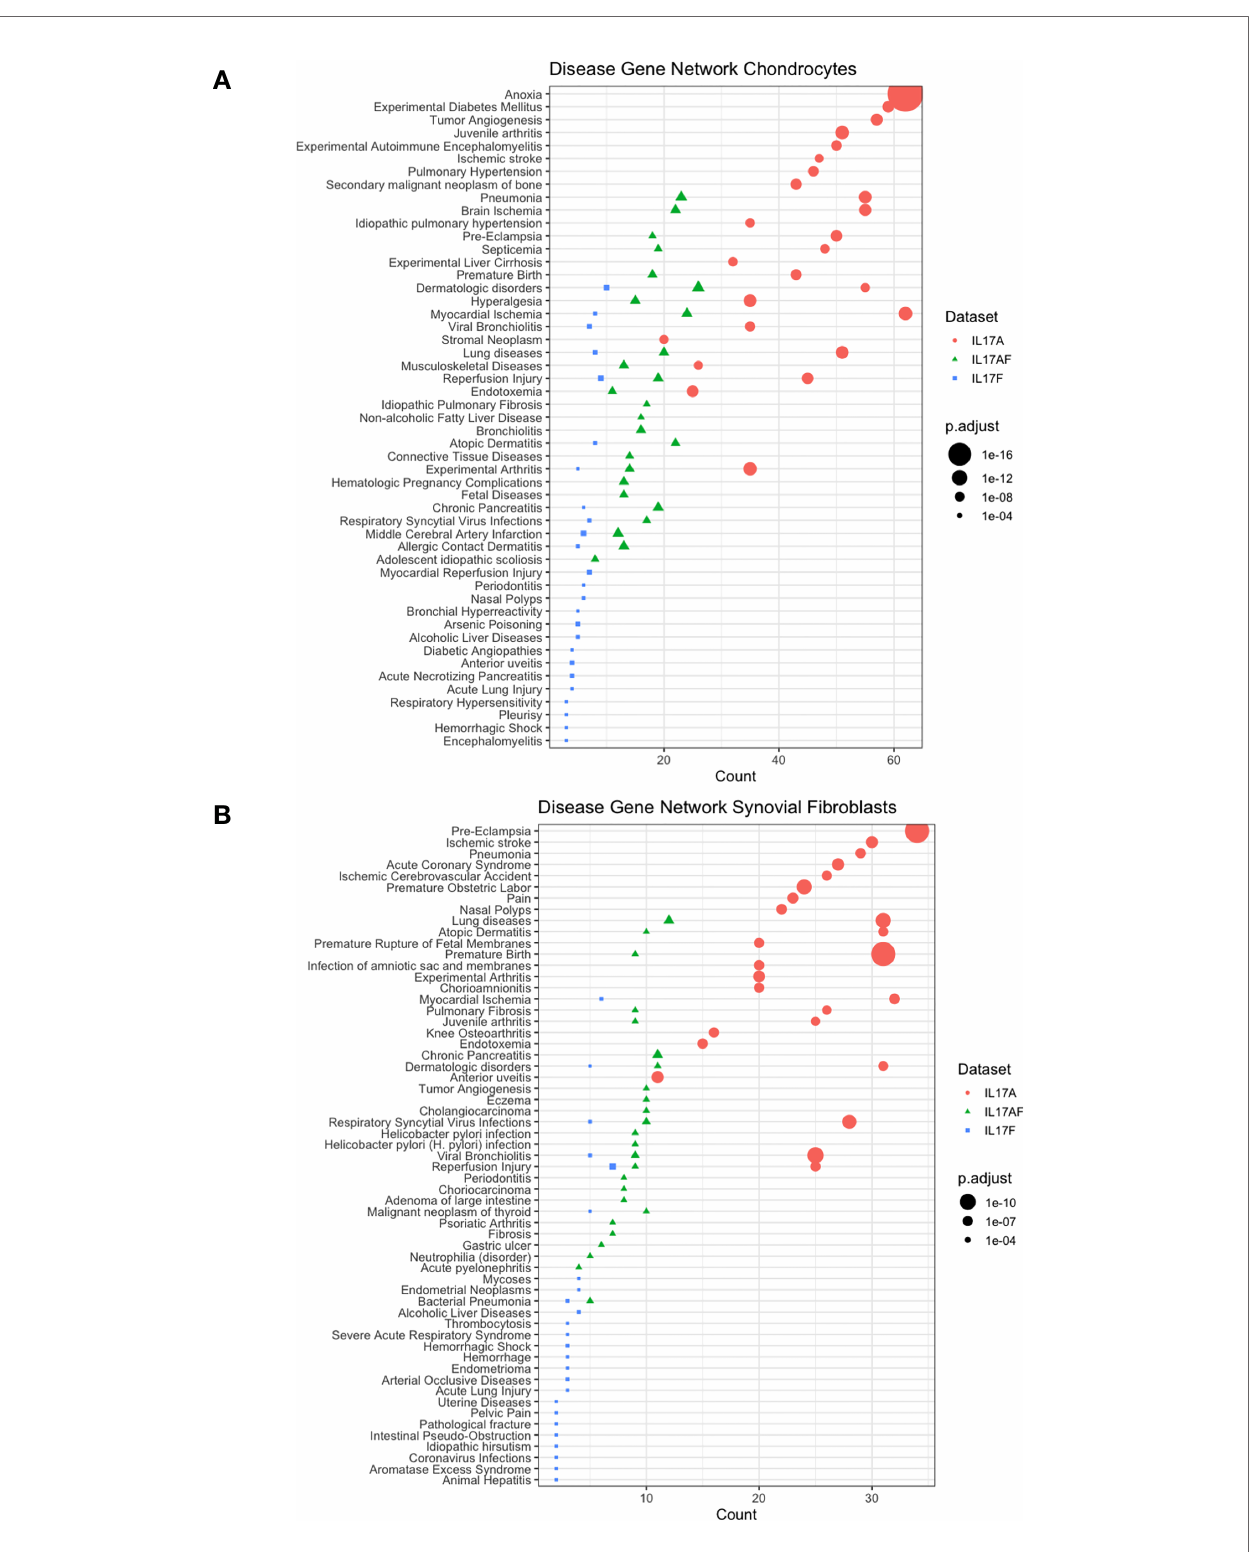
FIGURE 4 | Results from Disease-Gene Network (DiGeNeT) in (A) chondrocytes and (B) synovial fi broblasts. Dotplots displaying 25 most signi fi cantly associated disease gene sets with the differently expressed genes (DEGs) (padj<0.05, LFC ± 1) after treatment with IL-17A (coral), IL-17AF (green), and IL-17F (blue), including gene count (number of DEG in each disease geneset) and the adjusted